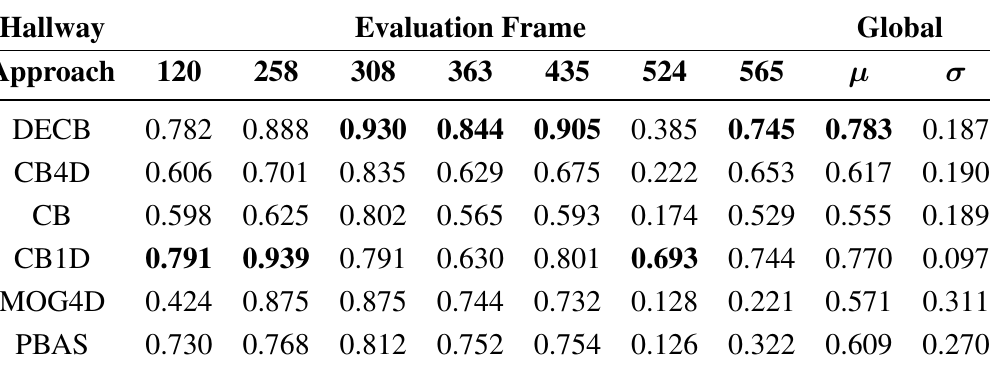
Table 5. Segmentation evaluation for sequence, Hallway. The table shows F the five studied approaches on seven different evaluation frames, the mean and standard deviation on the entire sequence.